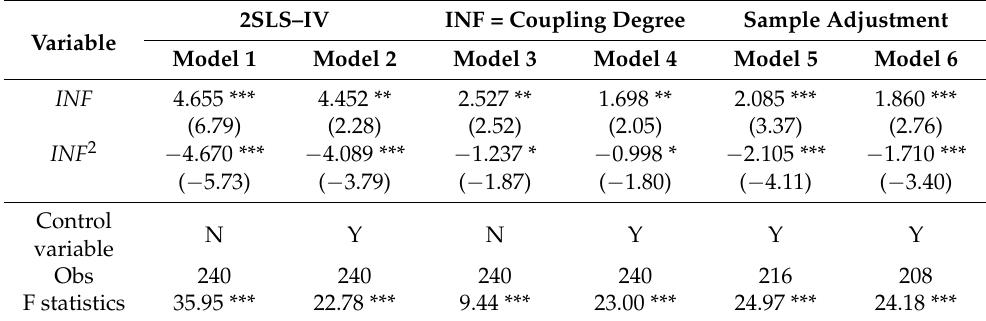
Table 6. Results of the robustness checks.